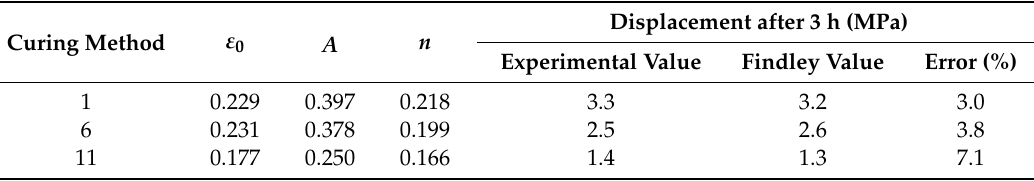
Figure 12. Comparison between experimental average curve and theoretical curve obtained with the Findley power law model for samples cured by method 1 (bending stress of 20 MPa). Table 4. Parameters of the Findley power law model for